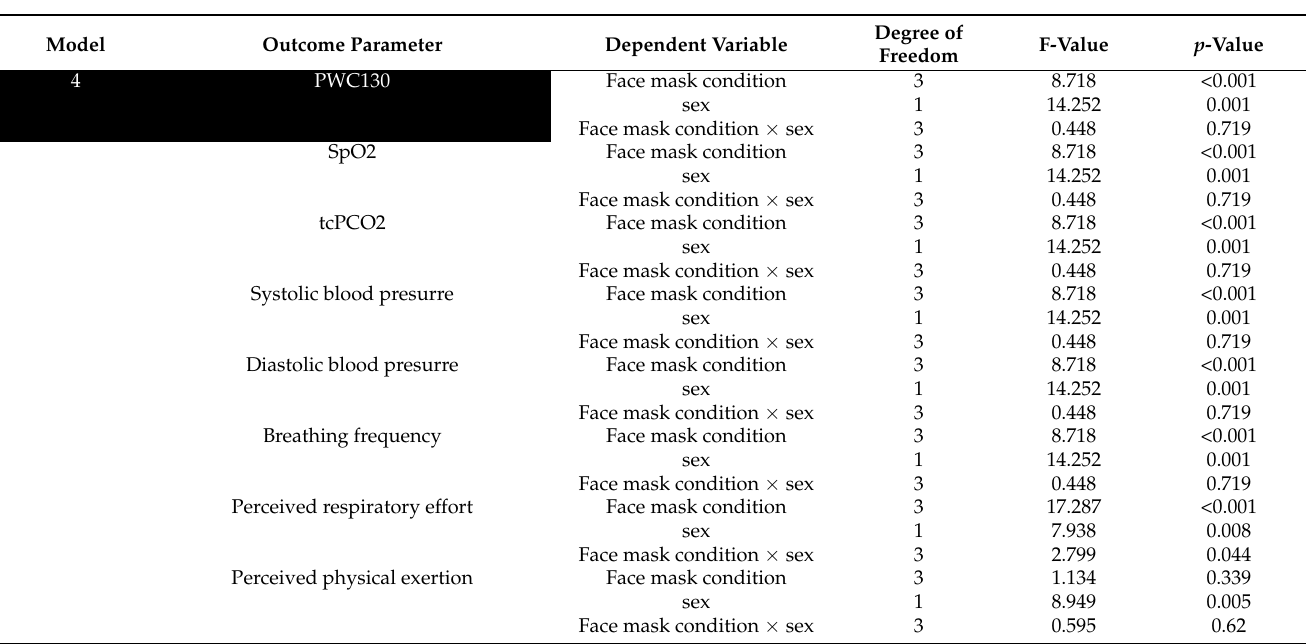
Table A7. Comparison of all face masks including face mask condition, sex, and the interaction term face mask condition x sex—linear mixed model